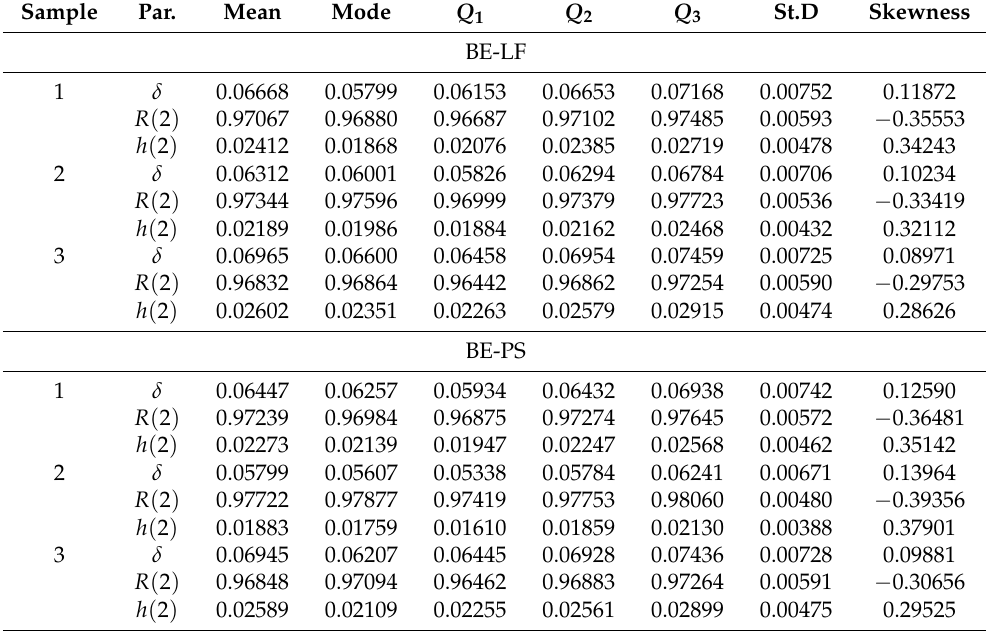
Table 10. Some properties of MCMC draws of δ , R ( t ) and h ( t ) from MVAD data.